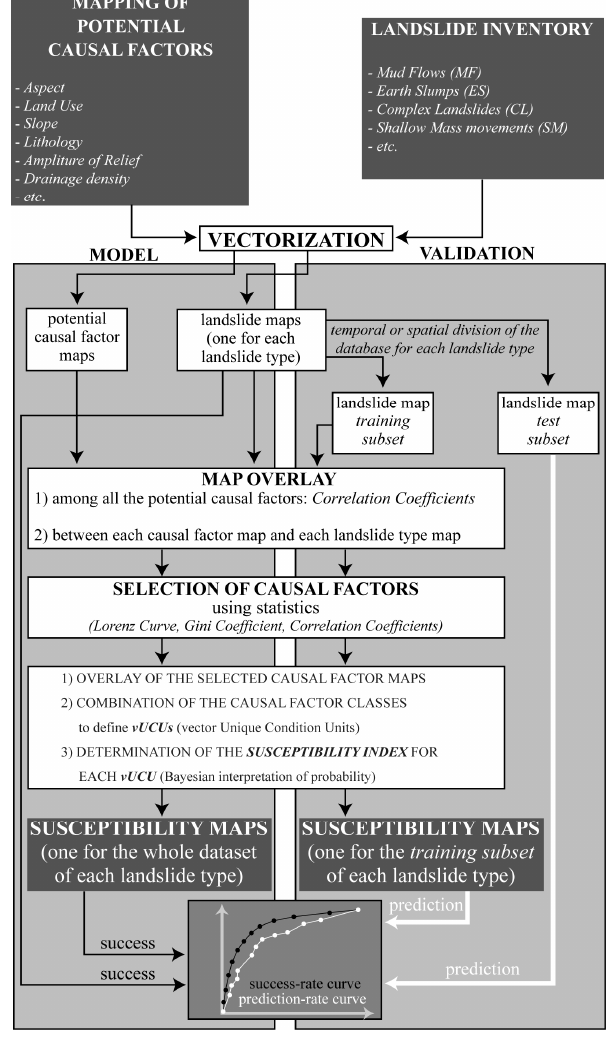
Figure 1: Landslide susceptibility assessment procedure. 2 Fig. 1. Landslide susceptibility assessment